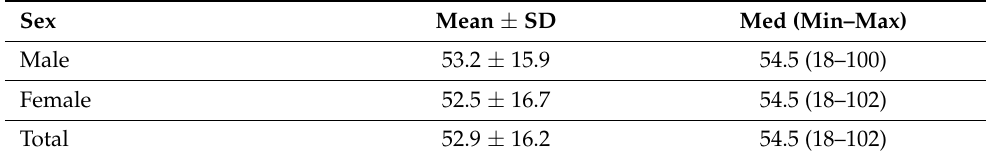
Table 2. Distribution of mean and median age of the participants by